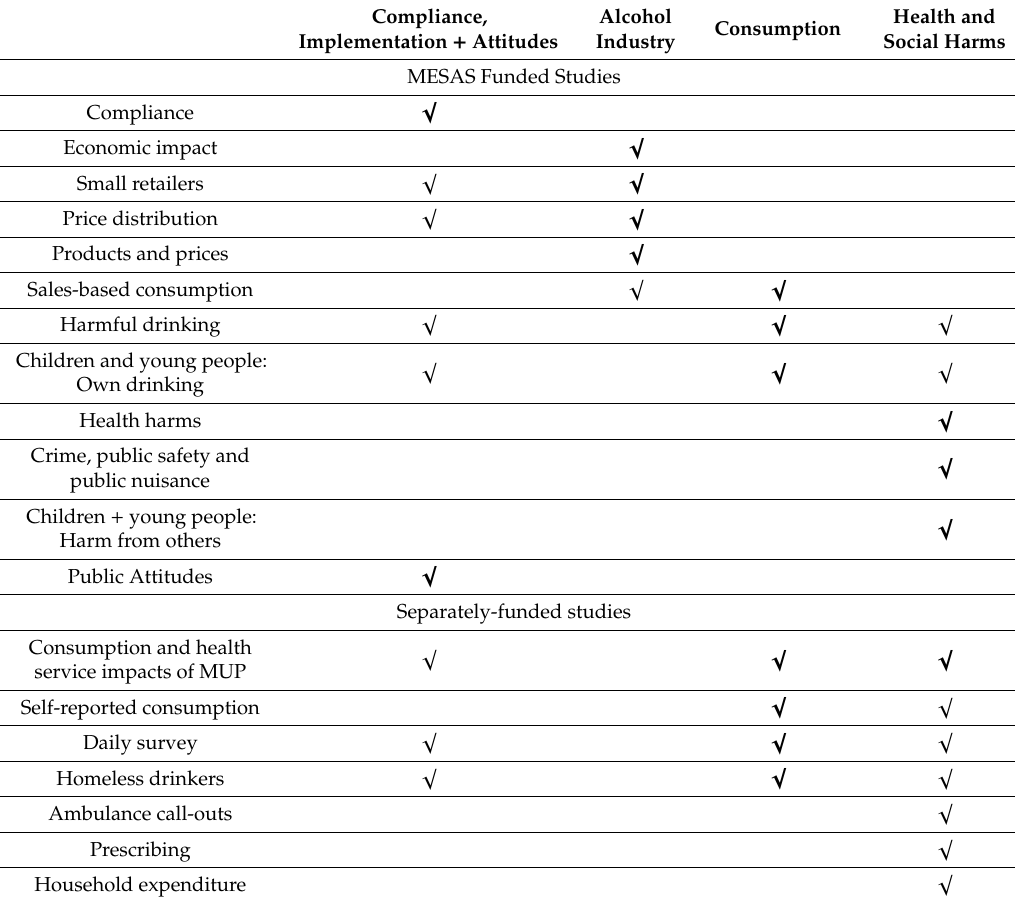
Table 1. List of Monitoring and Evaluating Scotland’s Alcohol Strategy (MESAS) and separately funded studies, and outcome